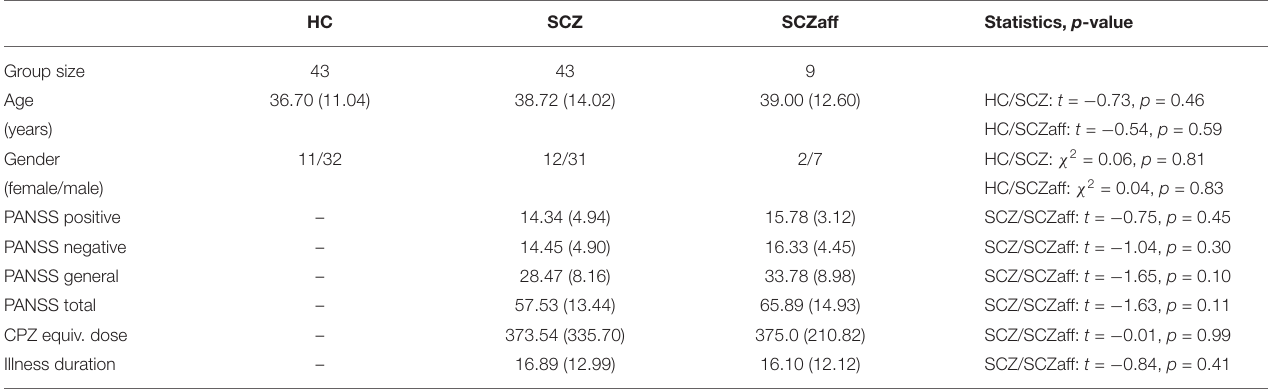
TABLE 1 | Demographics and clinical